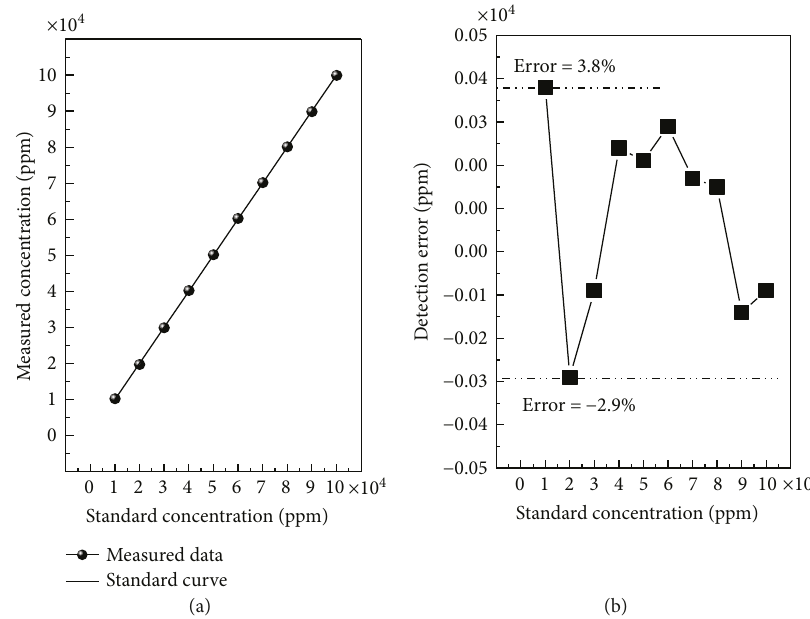
Figure 9: (a) Measured concentrations as well as standard concentrations and (b) relative detection error